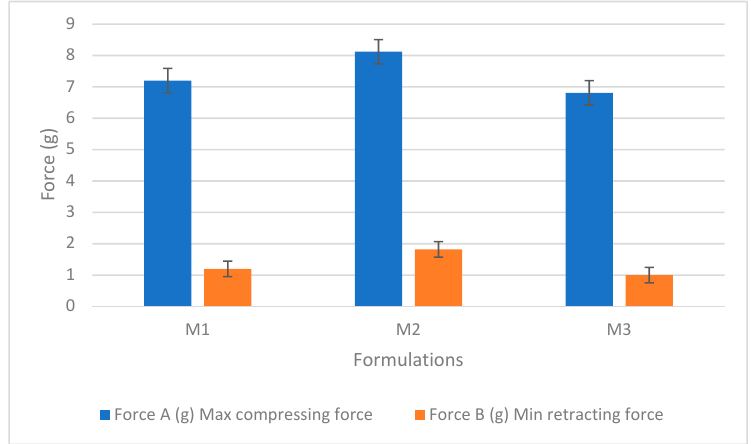
Figure 8. The compressing and retracting forces of the three hydrogel formulations (M1, M2, and M3). Results represent mean values ± SD. n = 3.